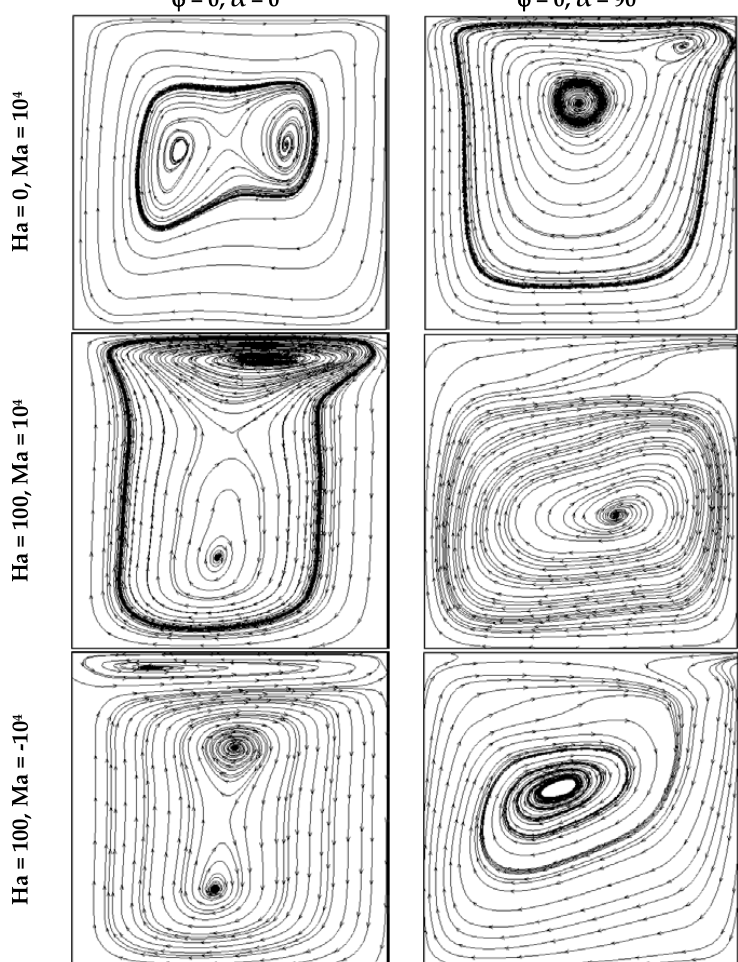
Figure 5. Velocity vectors projection on the central plan for Ra = 10 5 and ϕ = 0.